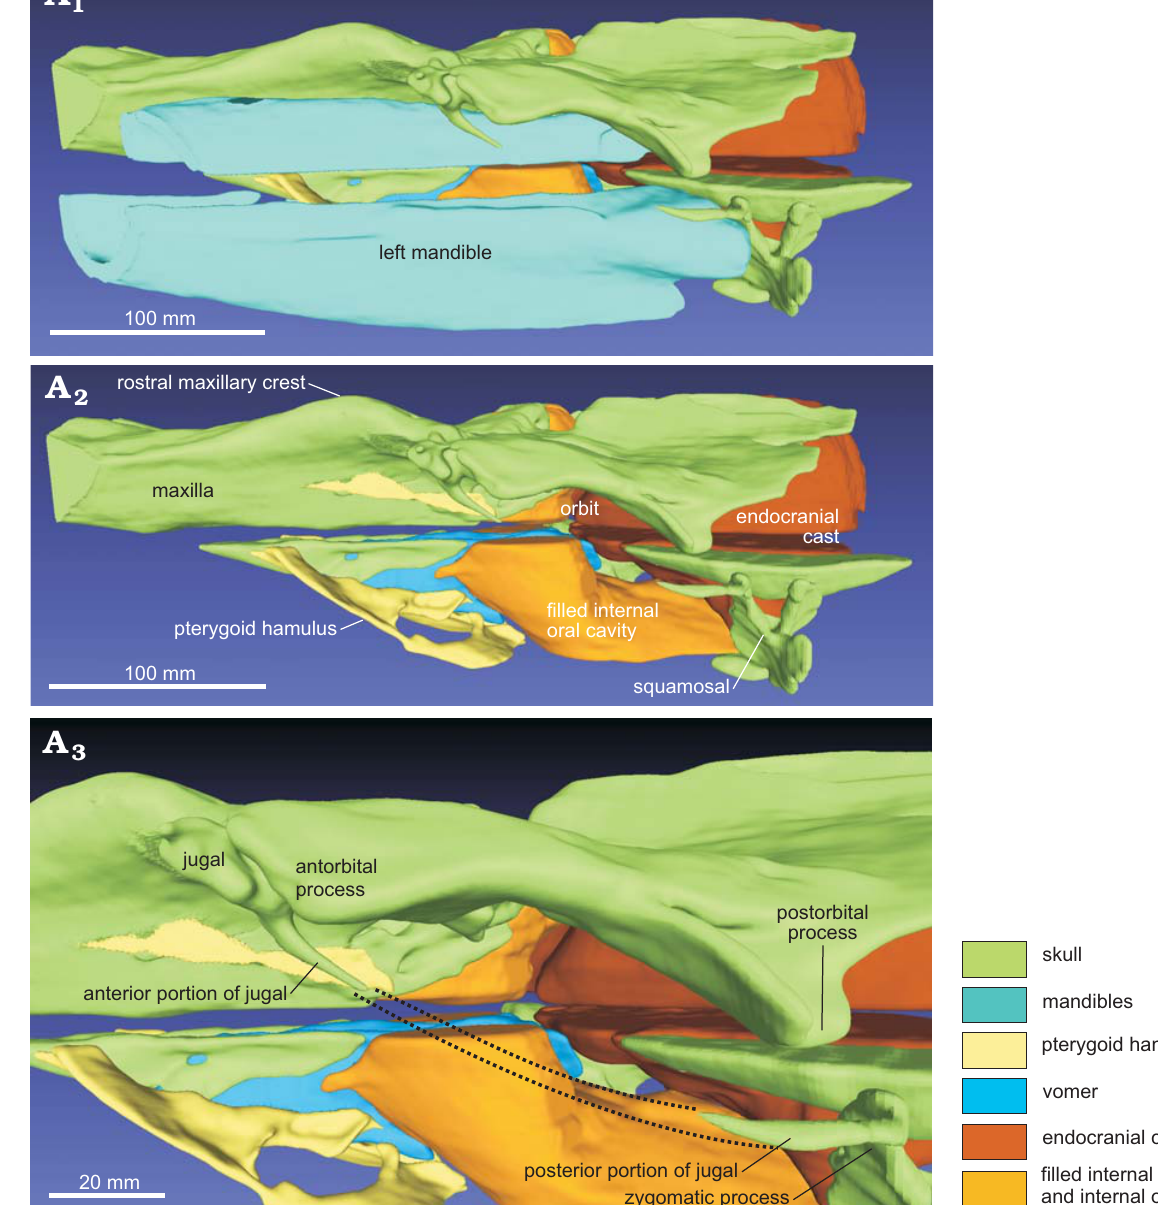
Fig. 7. 3D reconstruction resulting from the CT-scan of the ziphiid cetacean Messapicetus cf. longirostris Bianucci, Landini, and Varola, 1992 skull (MDM-2029) inside two limestone slabs from the Tortonian of Menorca (Balearic Islands, Spain); in left lateral view (A 1 ), left lateral view without the mandibles (A 2 ), detail of the orbital area (A 3